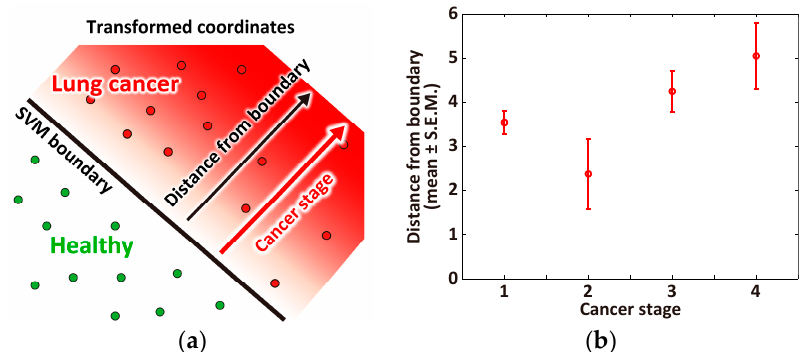
Figure 8. ( a ) Schematic illustration of the hypothesis that the cancer stage correlates with distance from the SVM boundary in the transformed coordinates space. ( b ) The y-axis indicates the distance from the SVM boundary. The learning VOC combination of the best TPR in Table 3 (butane, ethanol, acetone, C 2 H 3 CN, and toluene) was used for computing the test sample distance.